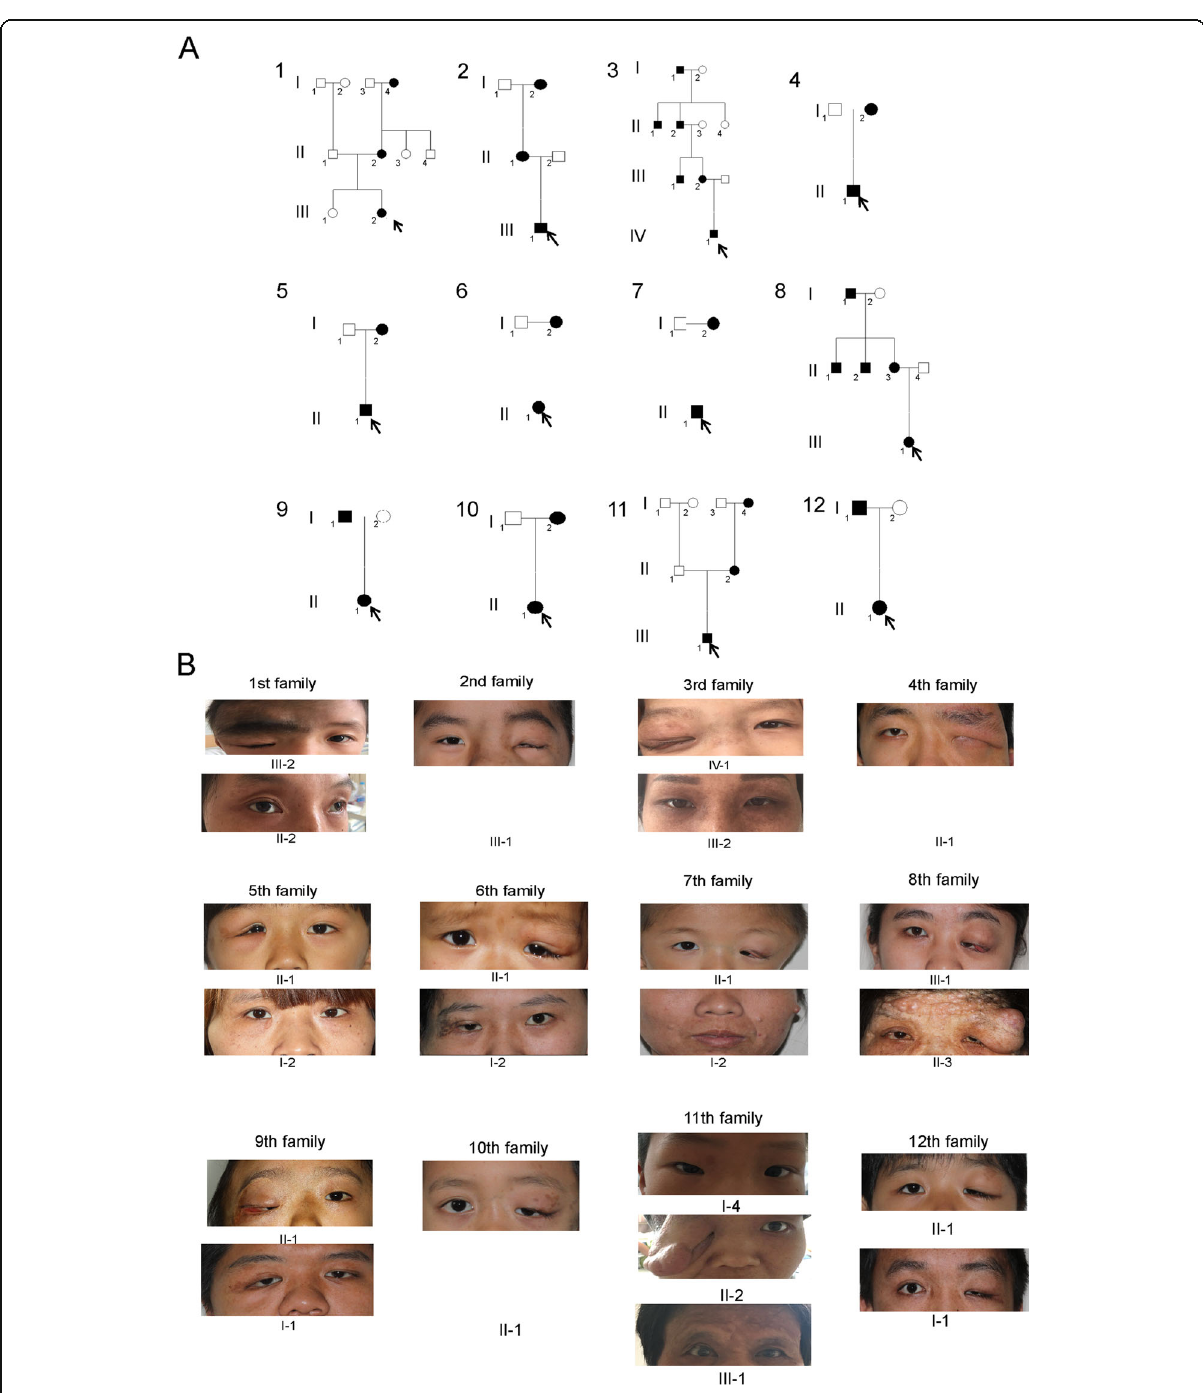
Fig. 1 a Genogram of 12 Chinese orbital/periorbital plexiform neurofibromatosis (OPPN) families. The status of affected (black symbol) represents OPPN disease. b Various clinical appearances of Chinese OPPN